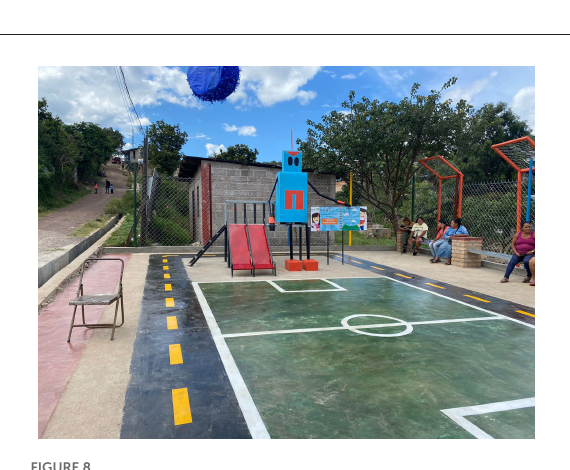
the gap between informality and formality and working toward a coordinated response (see Figure